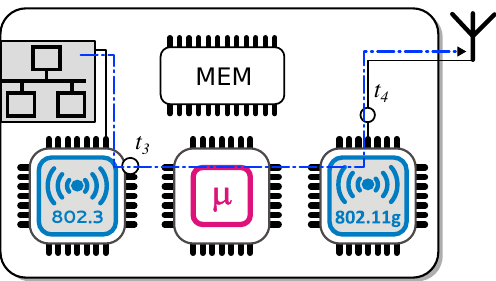
Figure 5. An illustration of the measurement points within the reference AP, used for measurements with the oscilloscope.